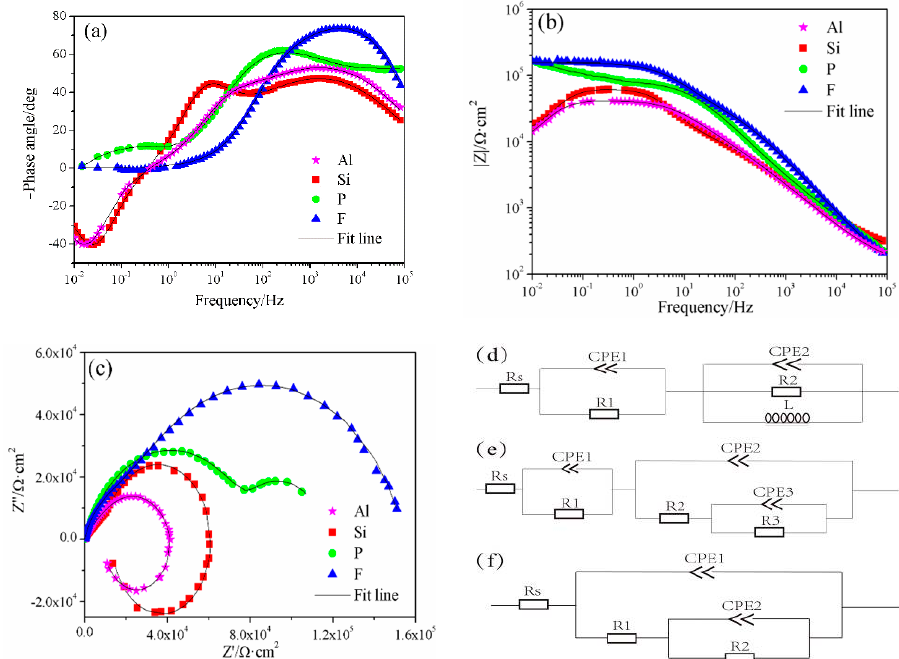
Figure 8. Electrochemical impedance spectra of the PEO-coated samples ( a , b ) Bode plots; ( c ) Nyquist plots; ( d – f ) the equivalent circuit employed to fit the spectra. Table 1. Evolution of calculated values of the equivalent circuit elements in Figure 8.